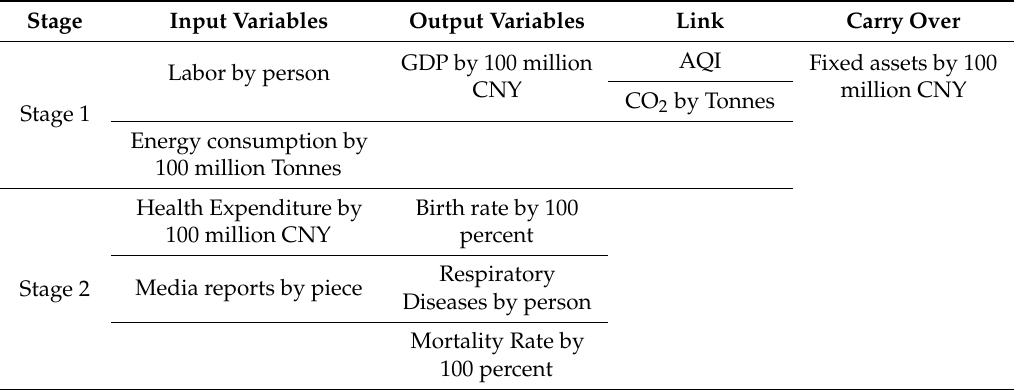
Table 2. Input and output